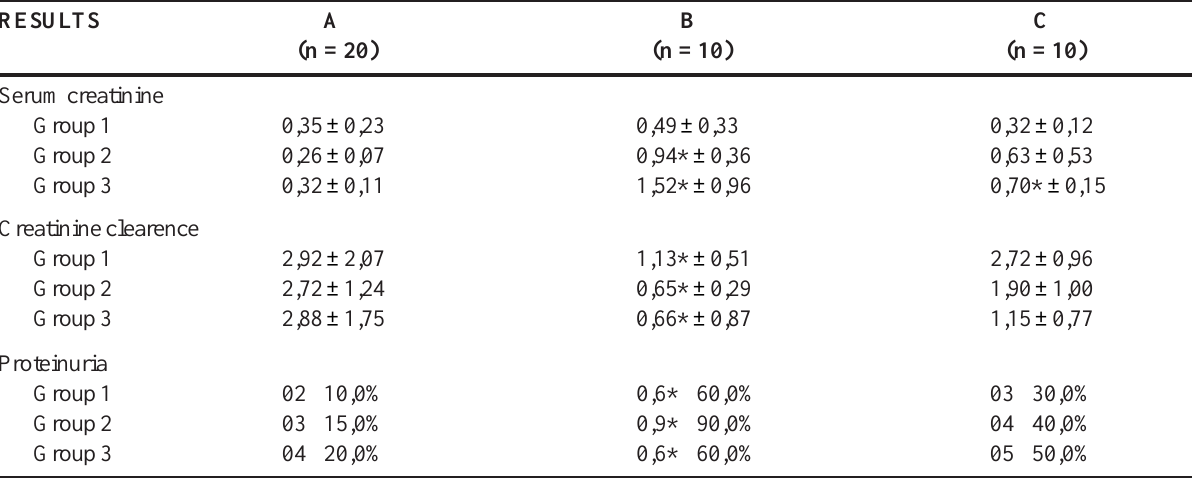
TABLE 2 - Results of creatinine (mg/dl), creatinine clearance (ml/min) and proteinuria (mg/dl)